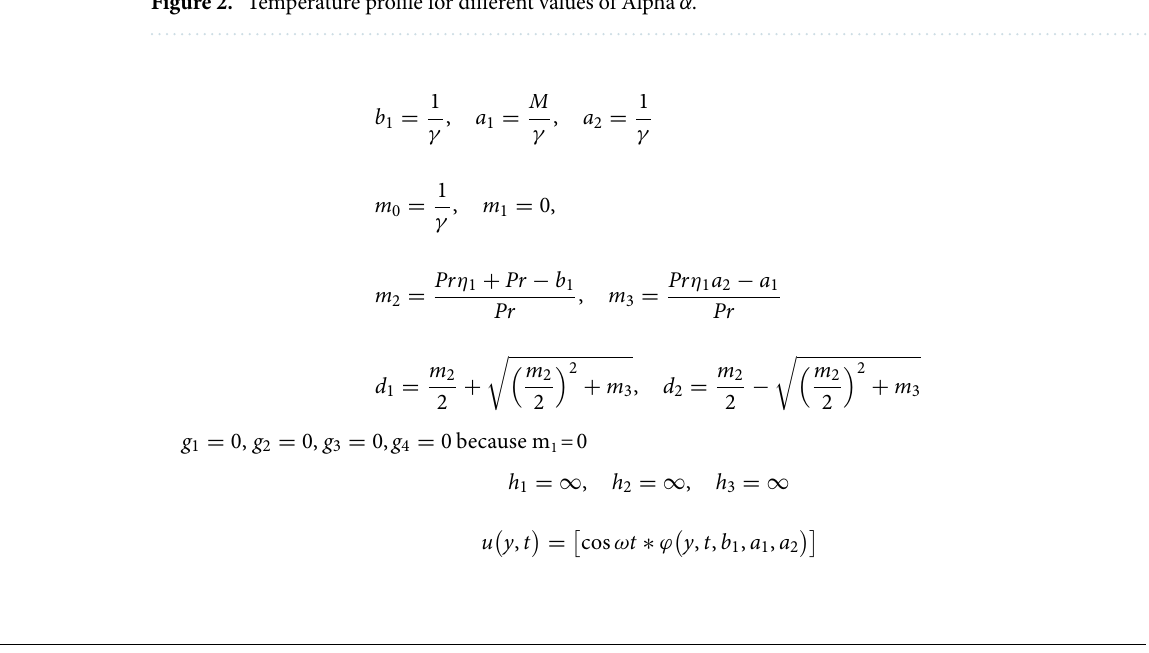
Figure 2. Temperature profile for different values of Alpha α